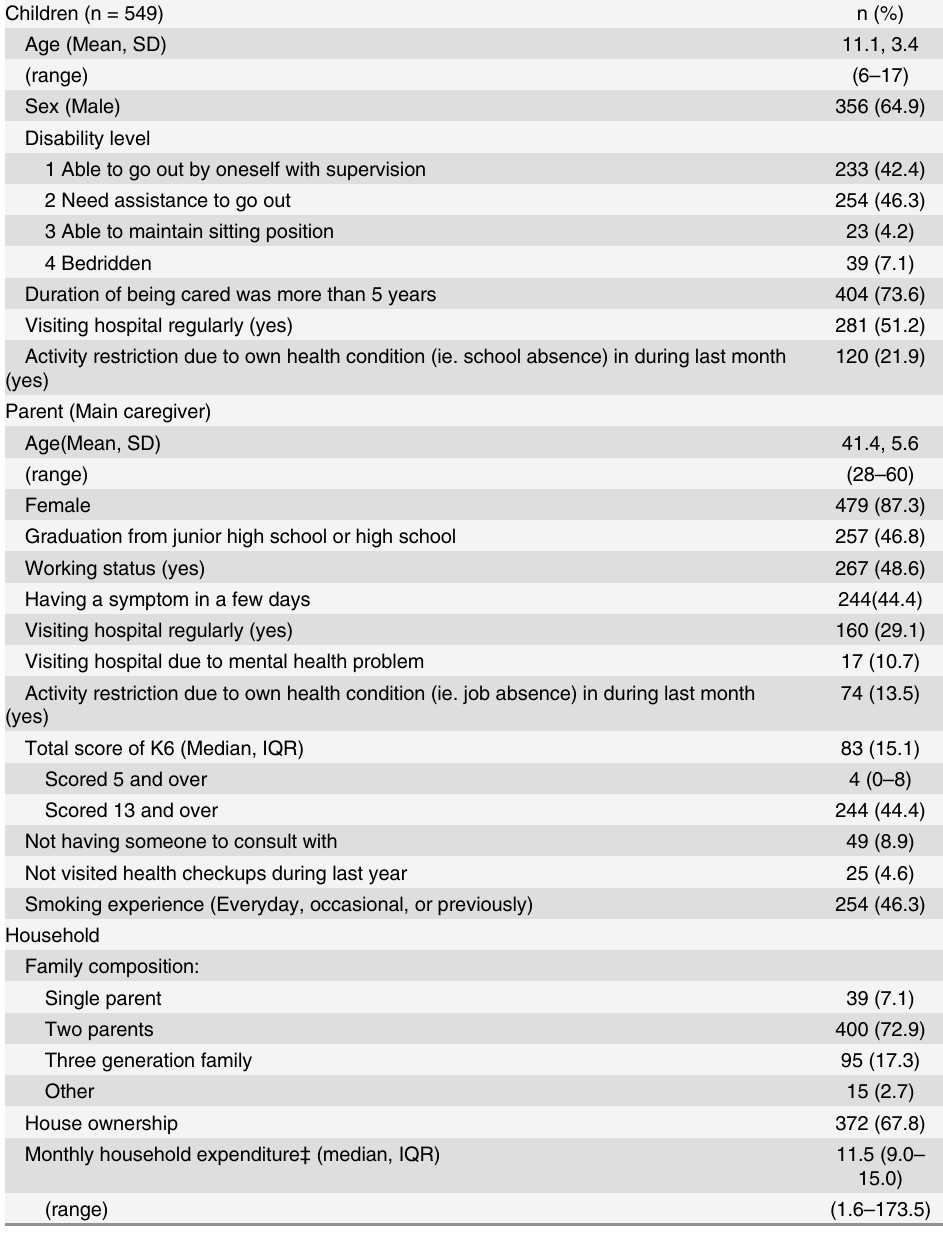
Table 1. Characteristics of children, their parent (main caregiver), and household. Children (n =